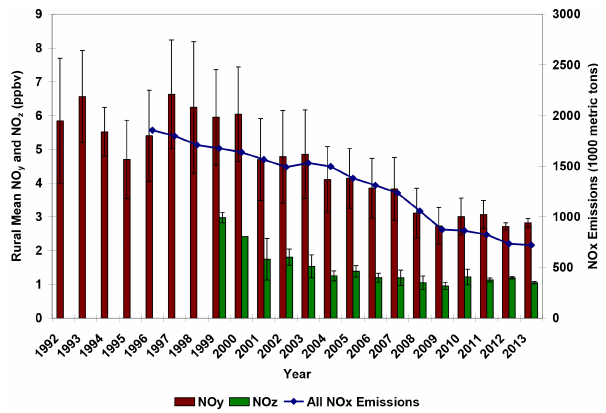
Figure 7. Mean annual NMOC concentrations at JST and emissions of VOC from on-road mobile exhaust within Georgia vs. year. Un- certainties are 1 standard error of the inter-site means. The 1998 NMOC measurements were made from August through Decem- ber. Emissions are updated from the NEIs, and from Blanchard et al.